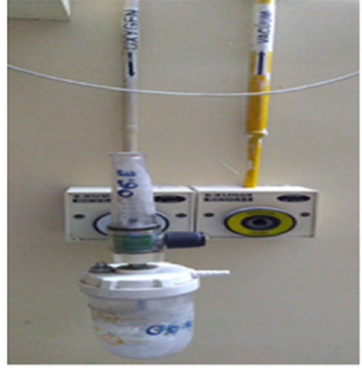
Figure 2. Oxygen supply system near to patient side.